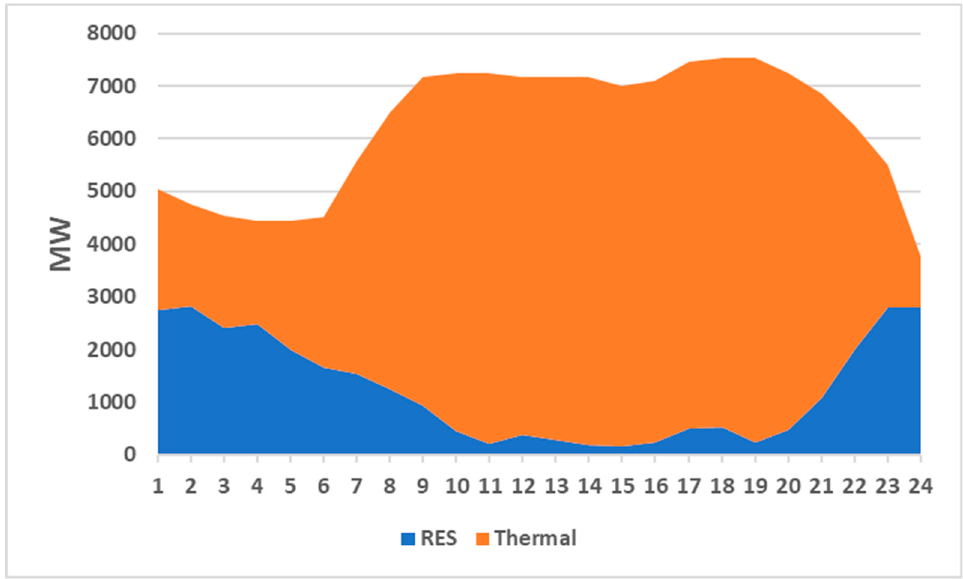
Table 3. Energy mix for different scenarios with the RUC model. 410